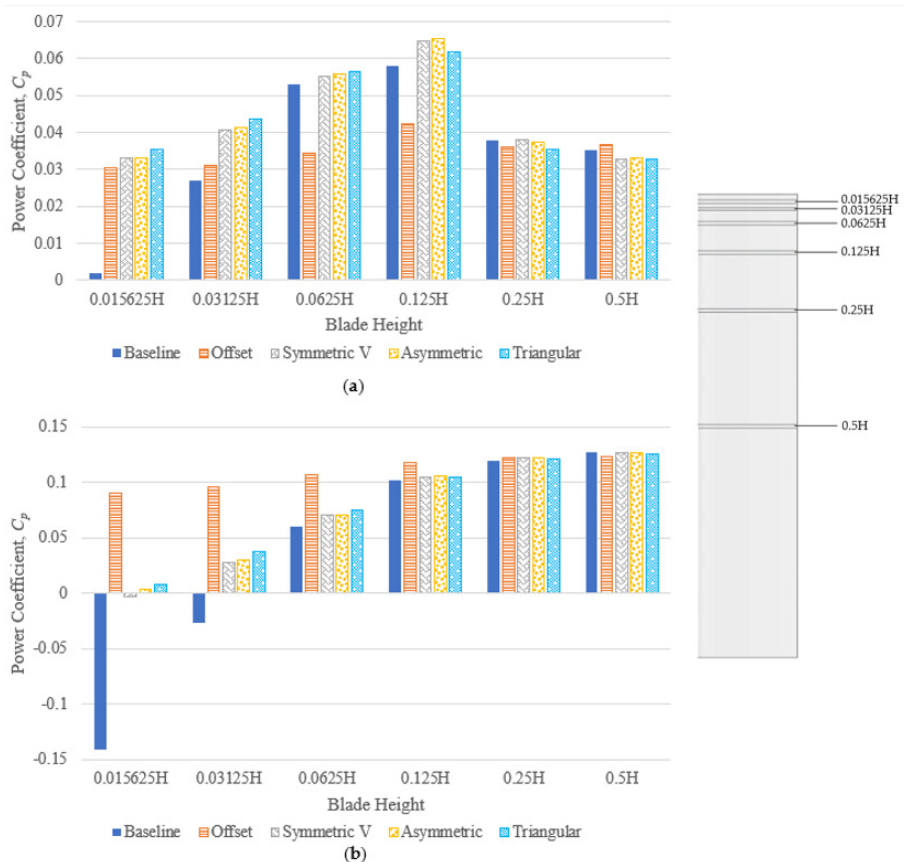
Figure 13. Breakdown of C P contribution on Blade 1 at different blade heights in ( a ) TSR 1 and ( b ) TSR 2.